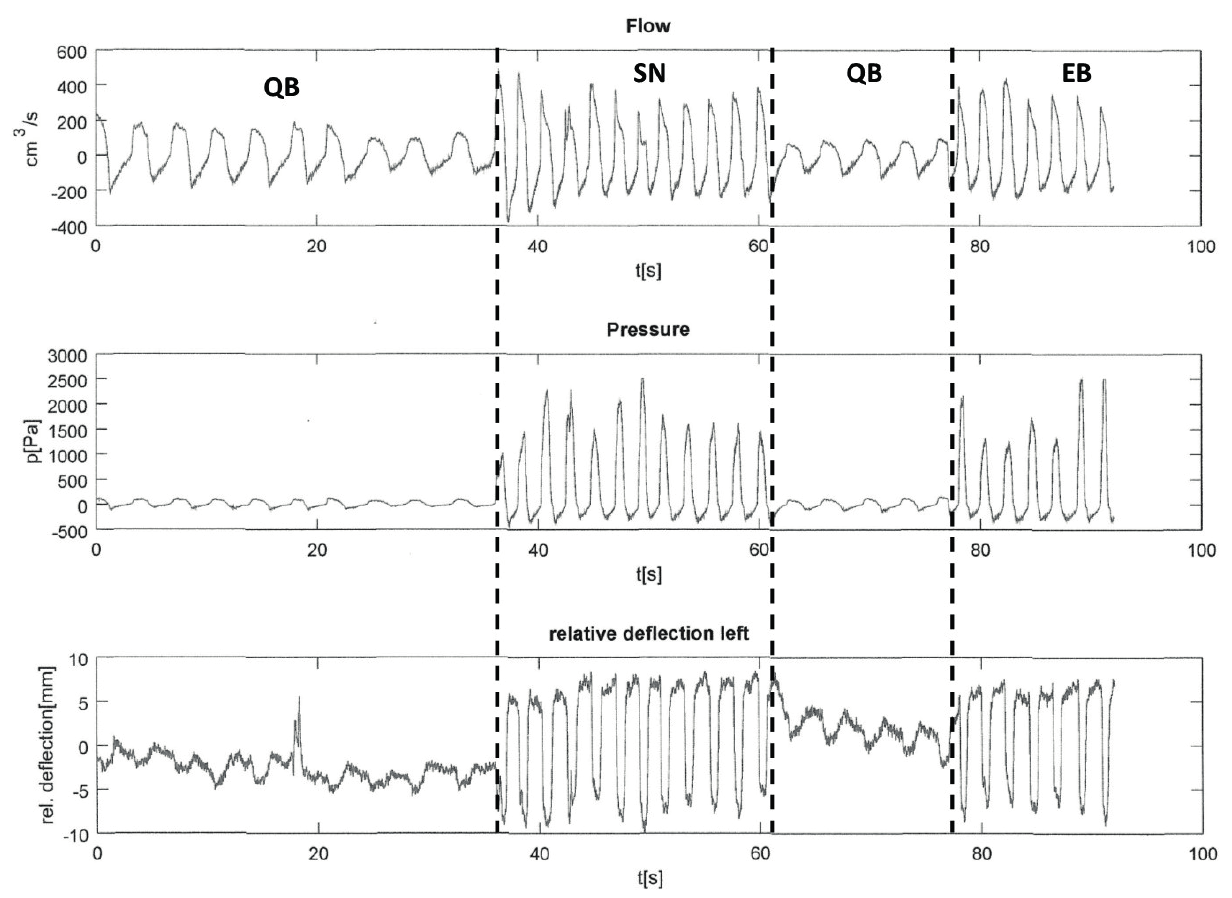
Figure 4. 3-channel-recording of flow, pressure, and relative deflection of the lateral nasal wall. QB quiet breathing, SN sniffing, EB elevated breathing.